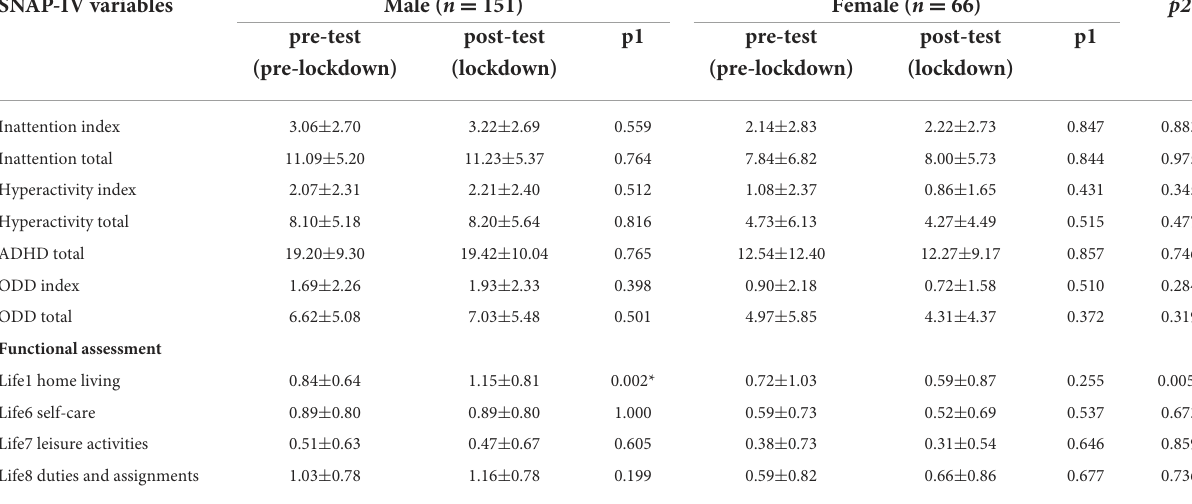
TABLE 3B Comparison of SNAP and the functional assessment of different genders during the lockdown and pre-lockdown